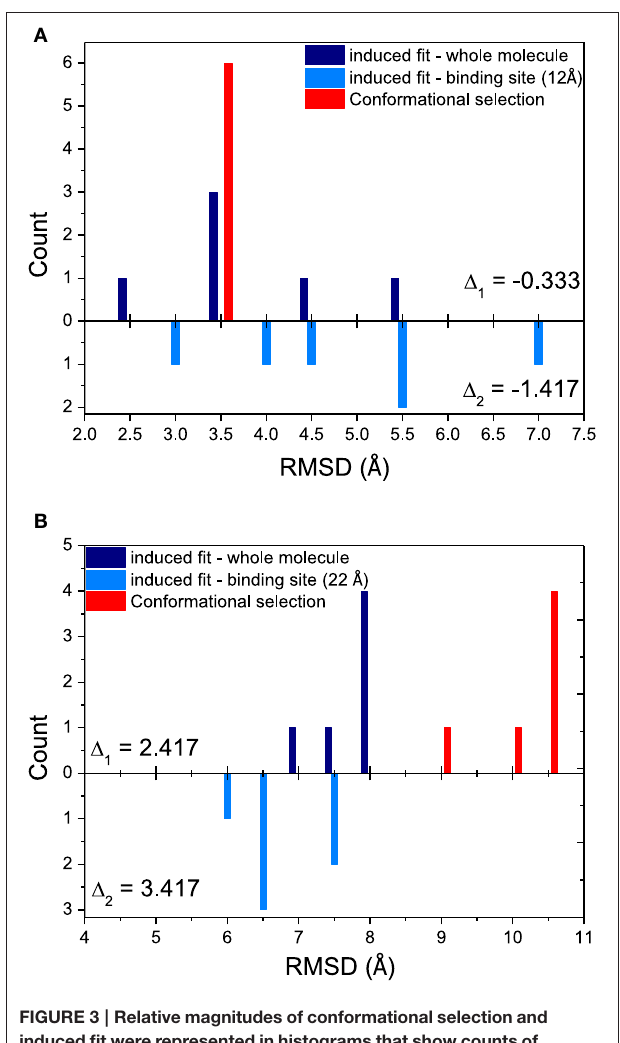
FIGURE 3 | Relative magnitudes of conformational selection and induced fit were represented in histograms that show counts of quantified RMSDs between: bound structures and most similar apo-structures in whole molecule (global induced fit, dark blue bars); bound structure and most similar apo-structure near binding site (local induced fit, light blue bars); and the most similar apo-structure and otherapo-structures(conformationalselection,redbars).(A) :DNA/RNA. (B) : Polymerase. 1 1 is calculated from CS − IF global , while 1 2 means CS − IF bindingsite